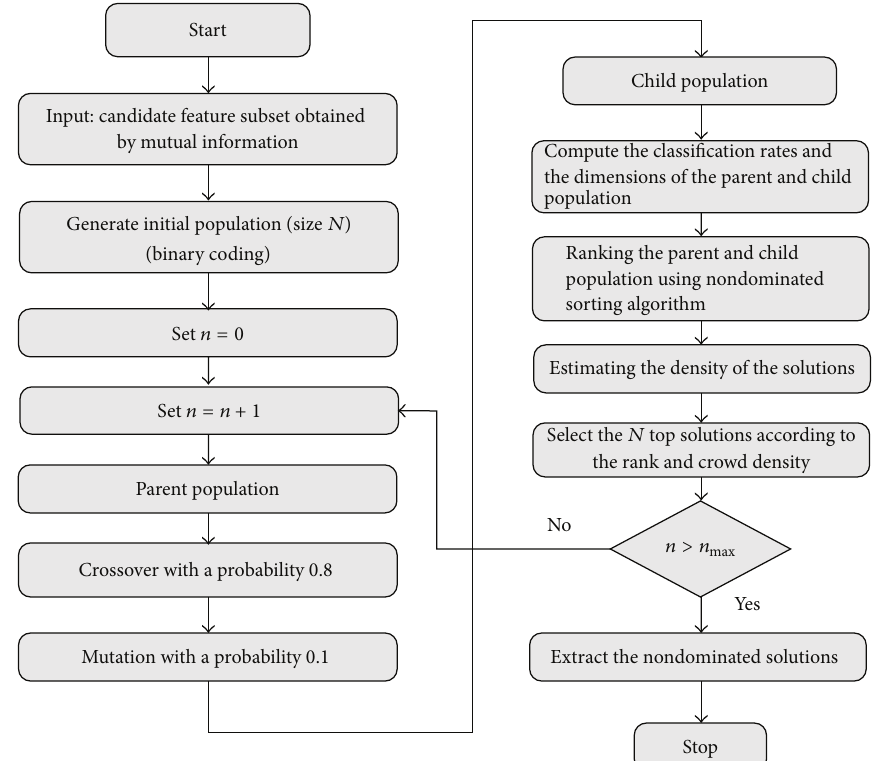
Figure 2: The schematic for applying the NSGA-II to the feature selection.